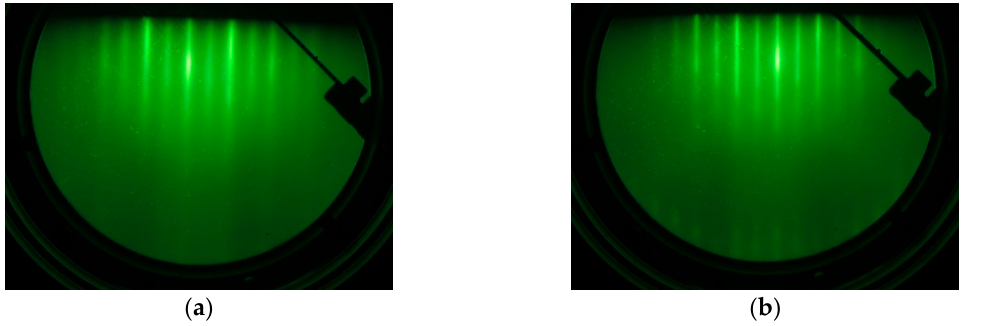
Figure 2. Reflection high-energy electron diffraction (RHEED) images of the GaO x layer grown on the ( a ) MgO underling layer and ( b ) Fe bottom electrode after an in-situ annealing ((110) azimuth of MgO substrate).